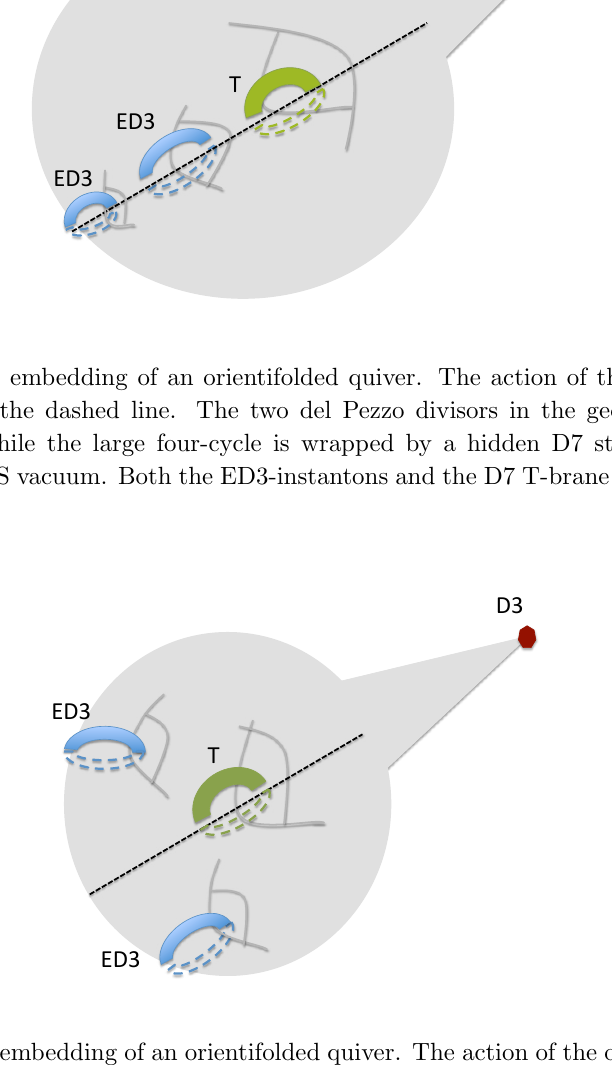
Figure 3 . Global embedding of an orientifolded quiver. The action of the orientifold is represented by the dashed line. The two del Pezzo divisors in the geometric regime are wrapped by ED3- instantons which are exchanged under the involution, and so lead to a U(1) instanton. The large (orientifold invariant) cycle is instead wrapped by a D7 T-brane stack that gives rise to a dS